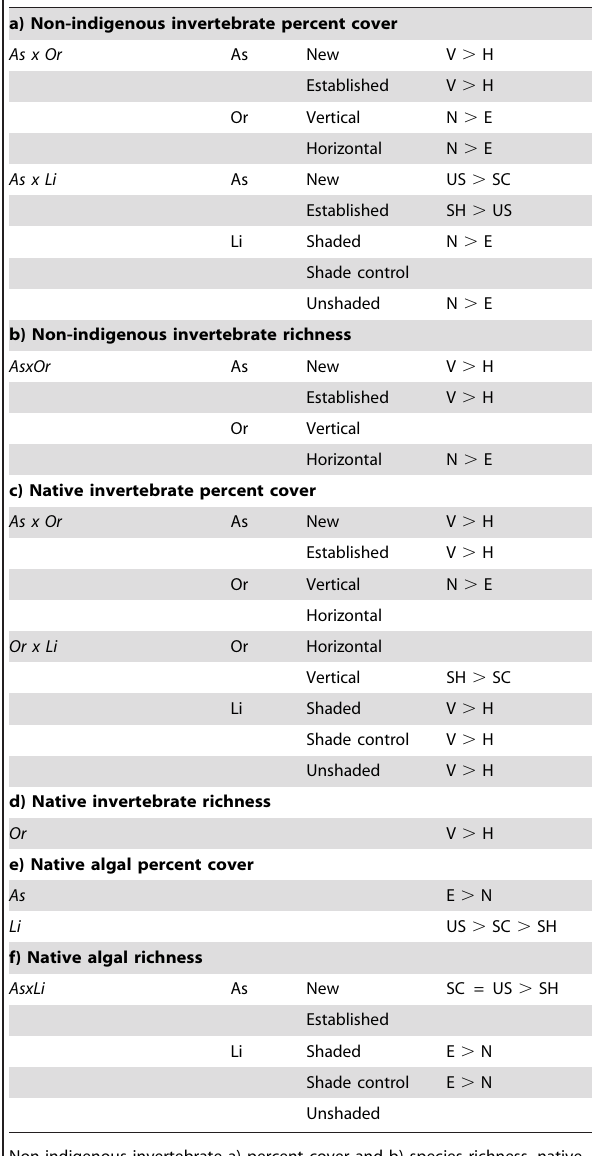
Table 6. Pairwise comparisons of the non-indigenous and native species percent cover and richness sampled from experimental ‘‘reef’’ (sandstone